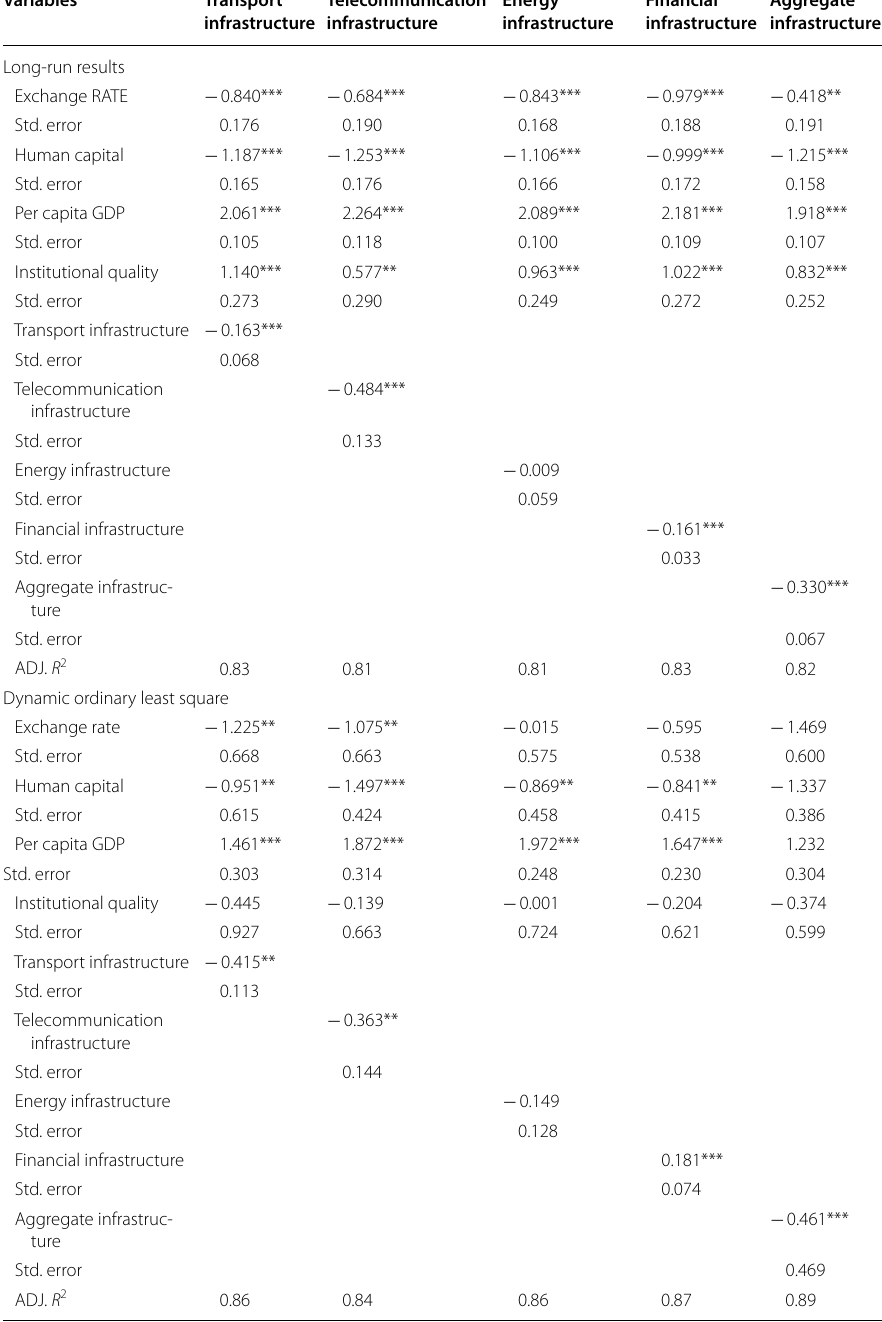
****, ** and * denote the significance at 1%, 5%, and 10%, respectively